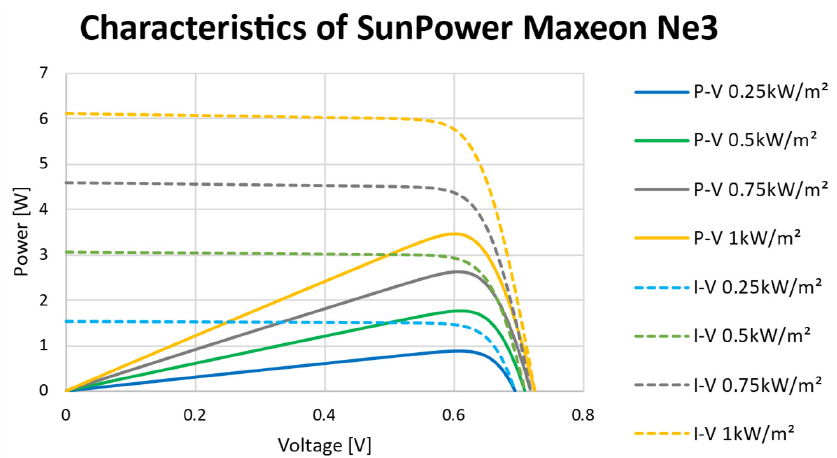
Figure 17. P-V and I-V characteristics of the laminated SunPower Maxeon Ne3 for different irradiance.